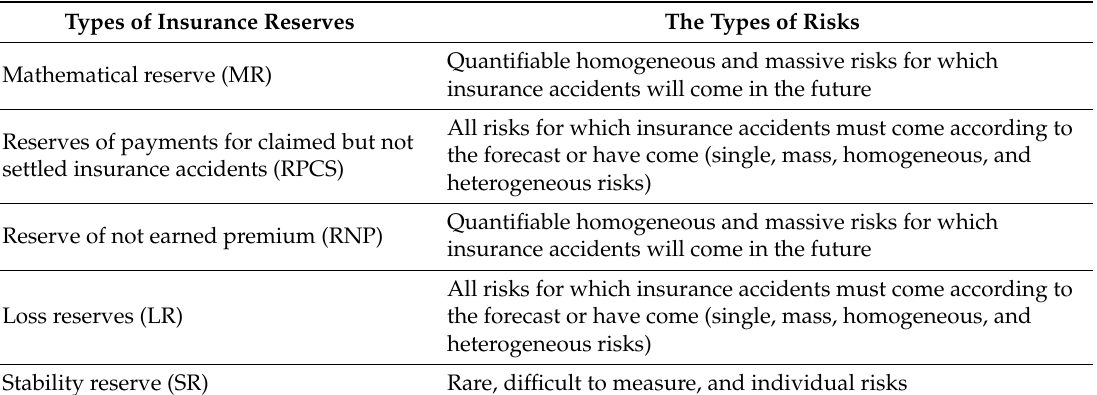
Table 4. The designated purpose of the insurance reserves (compiled by the authors based on Orlanuk-Malickaya and Janova